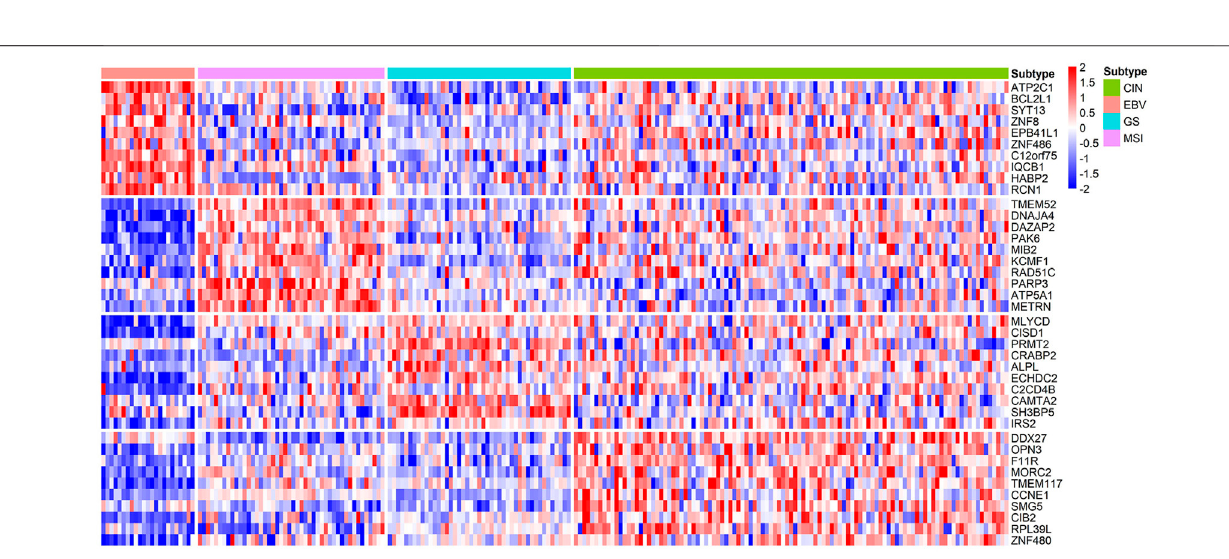
Frontiers in Genetics |